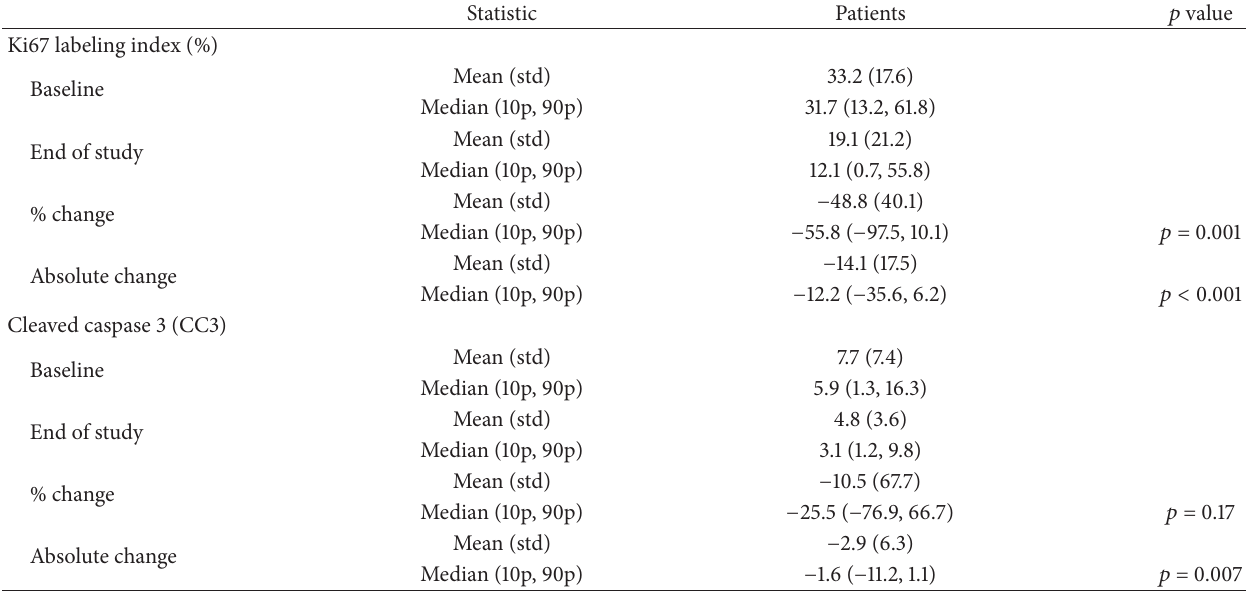
Table 2: Ki67 labeling index (%) and cleaved caspase 3 (CC3) at baseline (before anastrozole) and surgery (after anastrozole) on the 20 patients who completed the study.